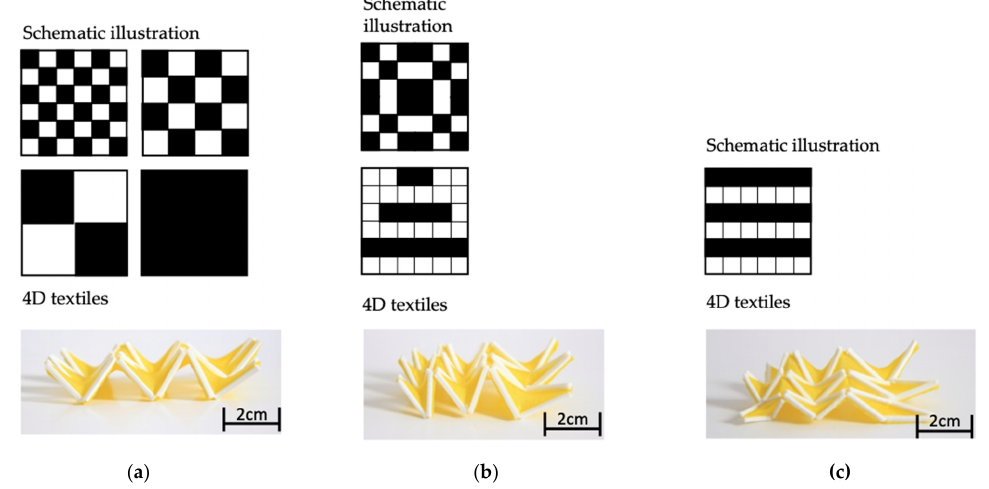
Figure 5. Material distribution design for 4D behavior: ( a ) uniform distribution with different concentrations; ( b ) gradual distribution; ( c ) special pattern.